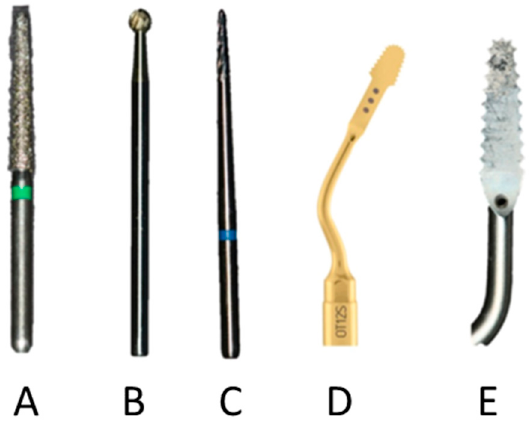
Figure 7. Tips/burs used for osteotomy in groups A, B, C, D, E.